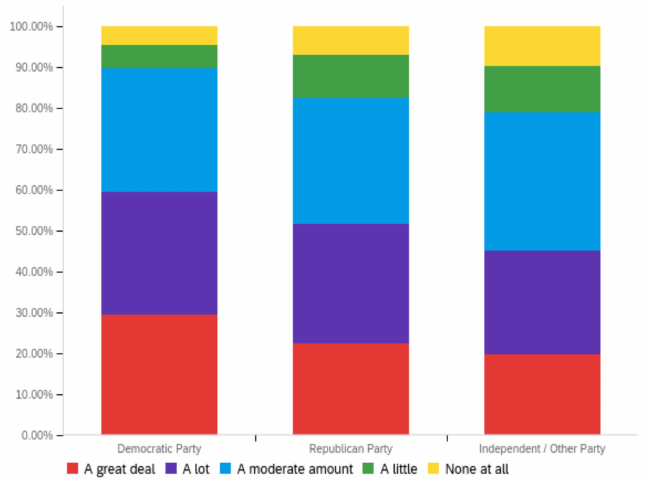
Figure 1. Article author—personal perception impact by political affiliation.